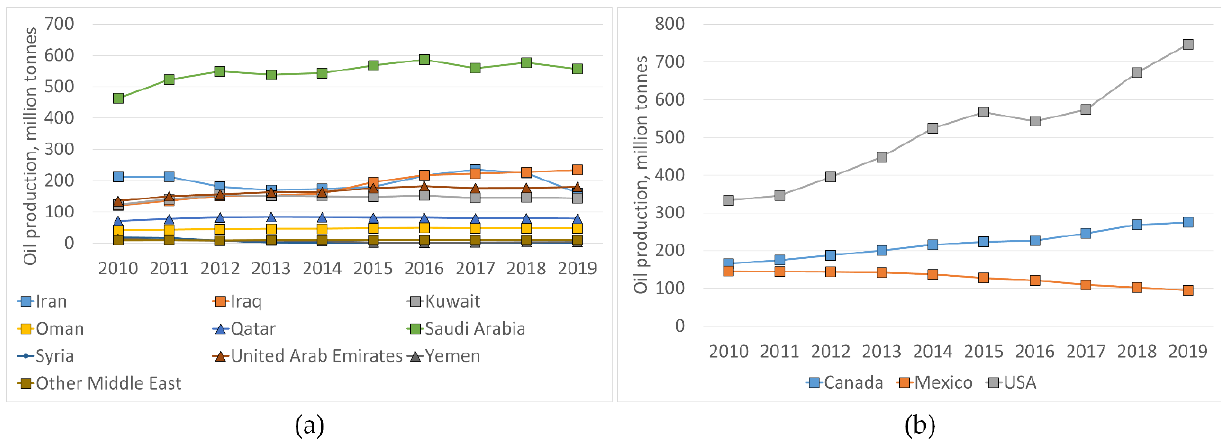
Figure 2. Volumes of oil production for the period from 2010 to 2019 in the countries of the regions: ( a ) the Middle East; ( b ) North America.